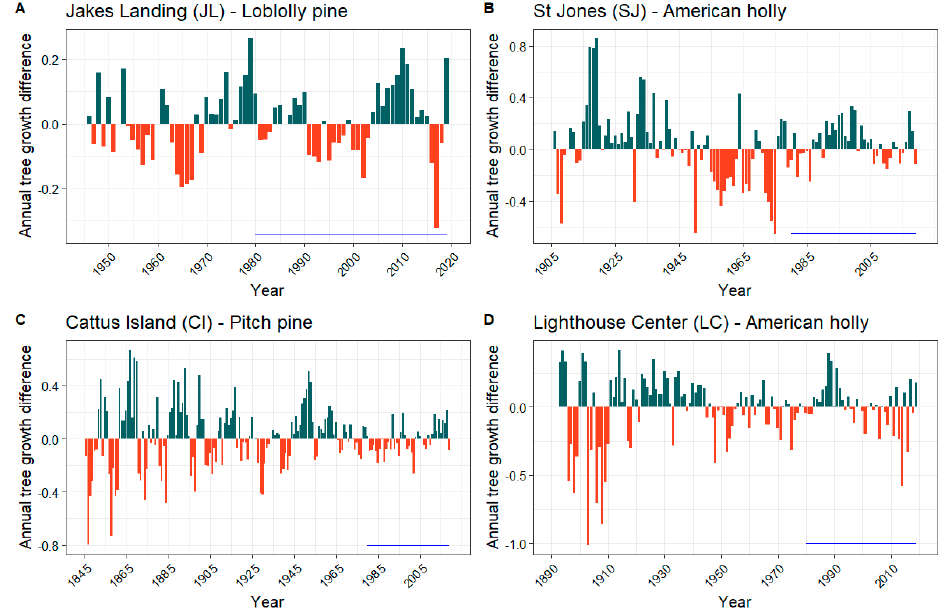
Figure 5. Chronologies of differences between high and low elevation trees for ( A ) Jakes Landing loblolly pines, ( B ) St. Jones American hollies, ( C ) Cattus Island pitch pines, and ( D ) Lighthouse Center American hollies. Chronologies of differences show where, on average, high elevation trees grew more (dark green) or less (light orange) than low elevation trees. The blue horizontal line in the bottom right of each graph shows the extent of the water level records (and therefore, the extent of the climatic data used in correlations), which was 1980–2019.